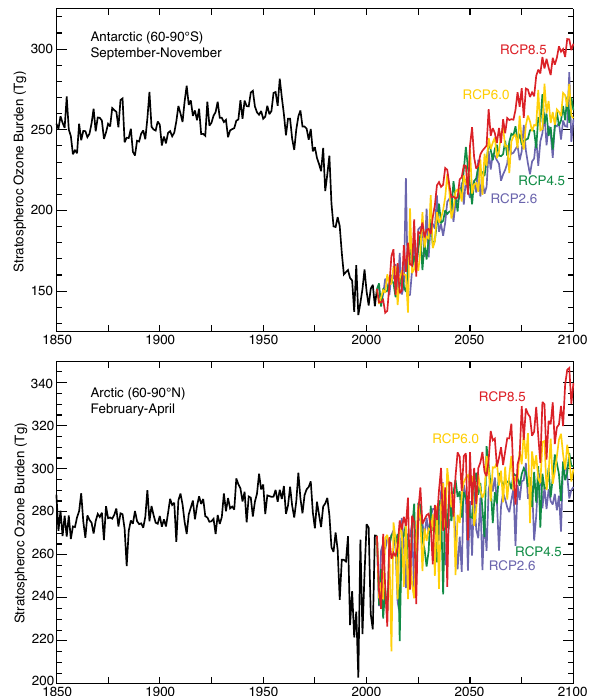
Fig. 18. Stratospheric ozone burden (top) and tropospheric ozone burden based on the 150ppb ozone chemical tropopause along with the ozone RF estimated using the burden times NRF (bottom, solid lines). Also shown are the tropospheric ozone forcings estimated for the four RCPs using the MAGICC model (dashed lines). The red solid circles show tropospheric ozone RF using the NCAR RTM and 150ppb ozone chemical tropopause.